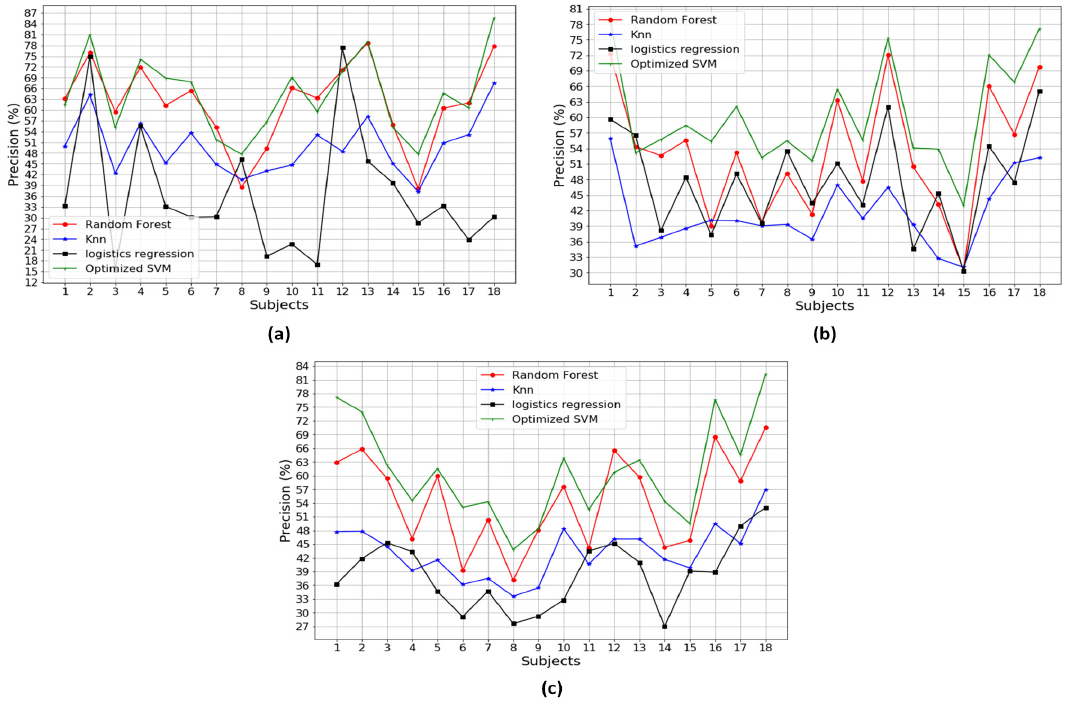
Figure A6. The average of precision performance over individual types of sensors: ( a ) precision over pressure sensor; ( b ) precision over accelerometer; and ( c ) precision over